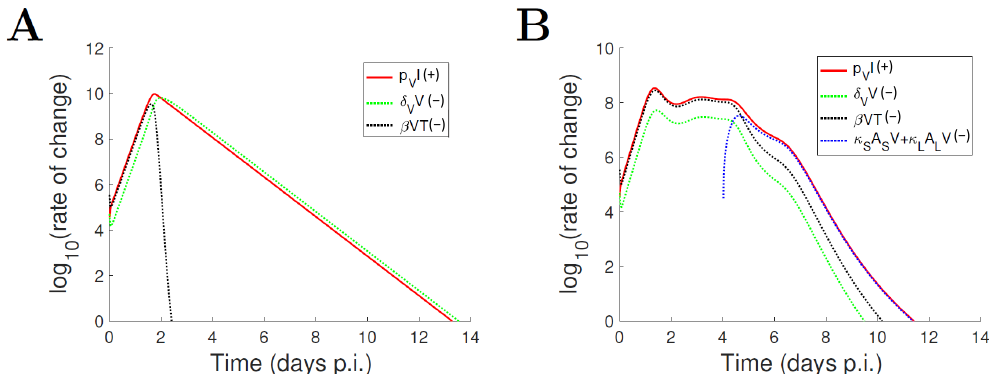
Figure 3. Results showing the contributions of various processes to the establishment of the viral load profile. ( A ) For the TIV model, three processes are involved: production of free virus ( p V I ), unspecified virus clearance ( δ V V ) and binding to target cells ( β VT ). The terms appear on the righthand side of Equation (3); ( B ) For the IR model, four processes are involved: production of free virus ( p V I ), unspecified virus clearance ( δ V V ), binding to target cells ( β VT ) and virus neutralisation by antibodies ( κ S A S V + κ L A L V ). The terms appear on the righthand side of Equation (4). The processes leading to an increase in viral load are labelled by (+) and shown by solid curves, while the processes reducing the viral load are labelled by ( − ) and shown by dotted